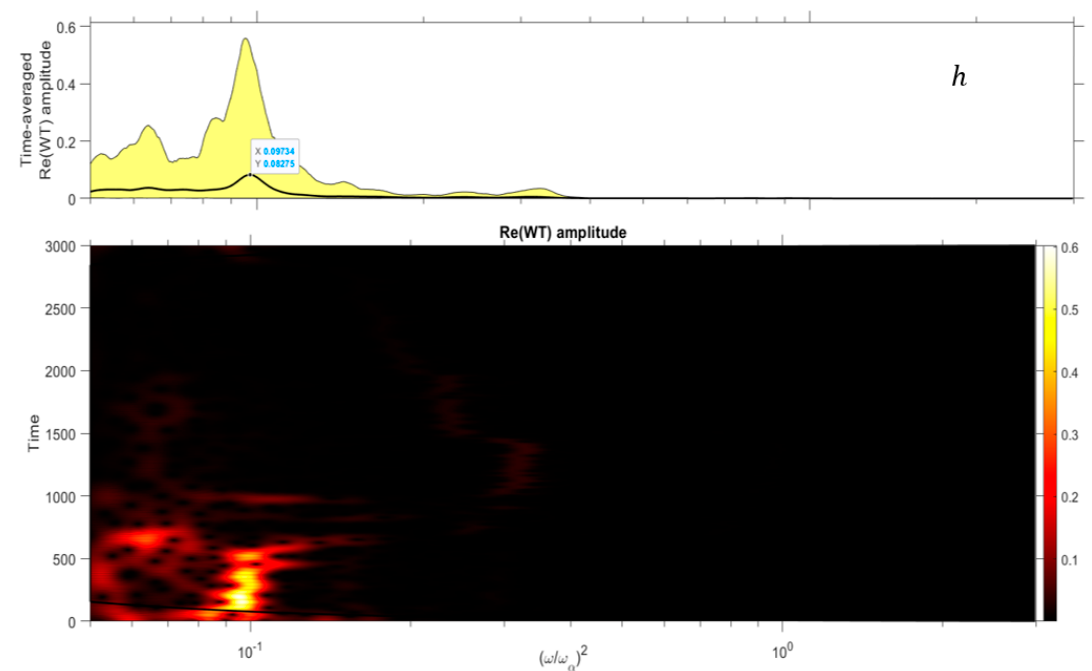
Figure 11. Time–frequency analysis: Bending ( 𝑄 (cid:3042) = 15.6 ).